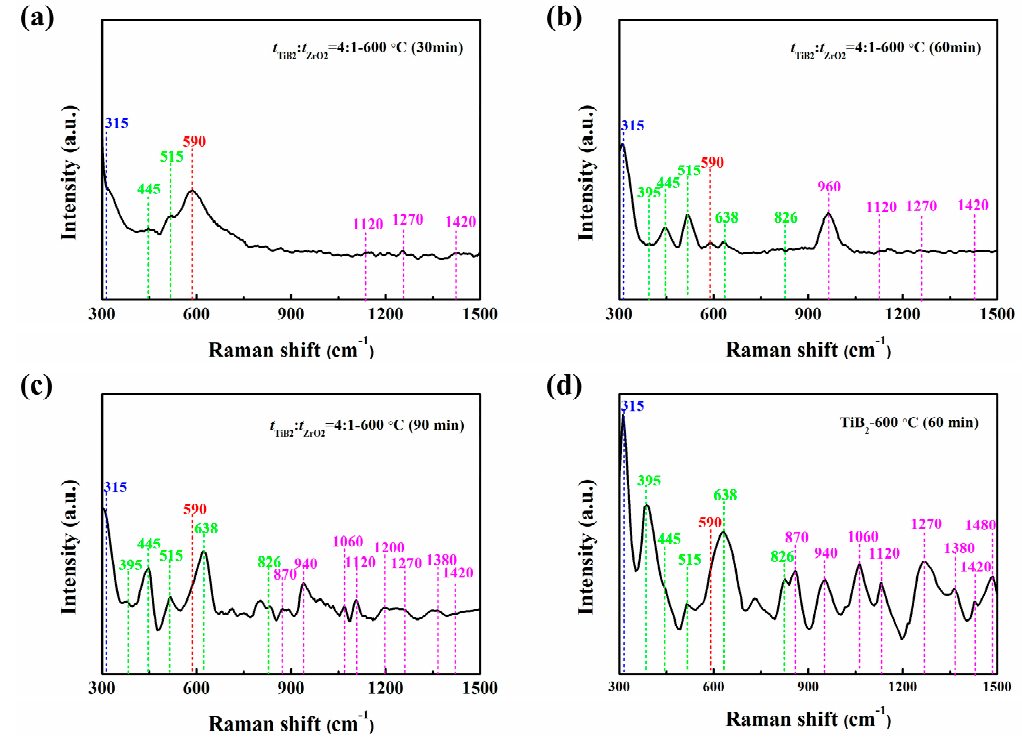
= 4:1) multilayers after annealing for ( a ) : t ZrO 2 2